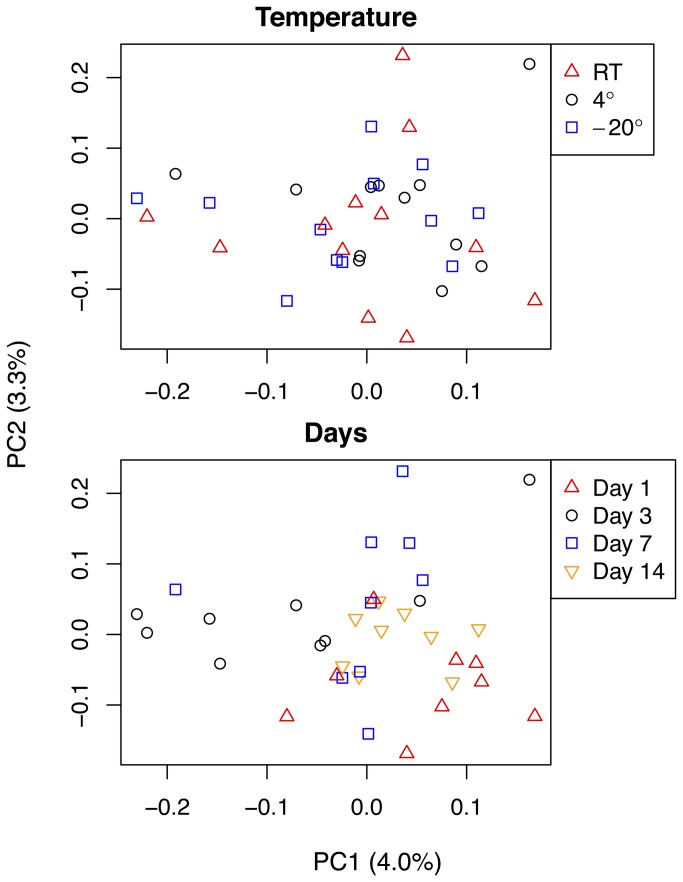
Principal coordinates plots showing similarities of samples between temperature treatments and time treatments.Pairwise unweighted UniFrac distances were used to generate plots.